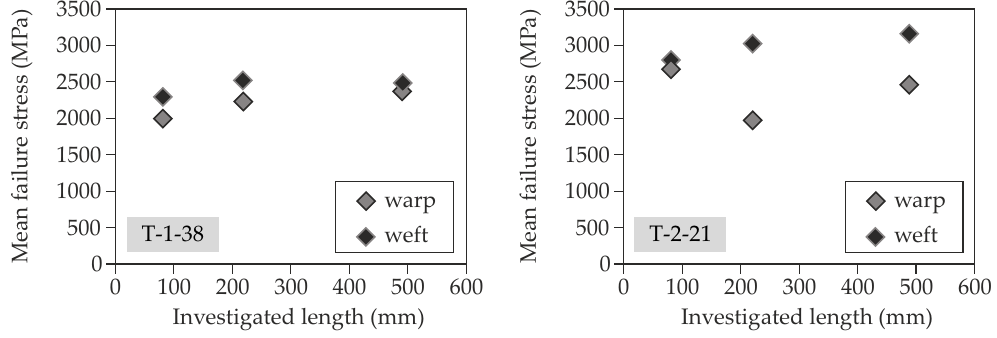
Figure 6. Results of tensile tests on yarns for T-1-38 ( a ) and T-2-21 ( b